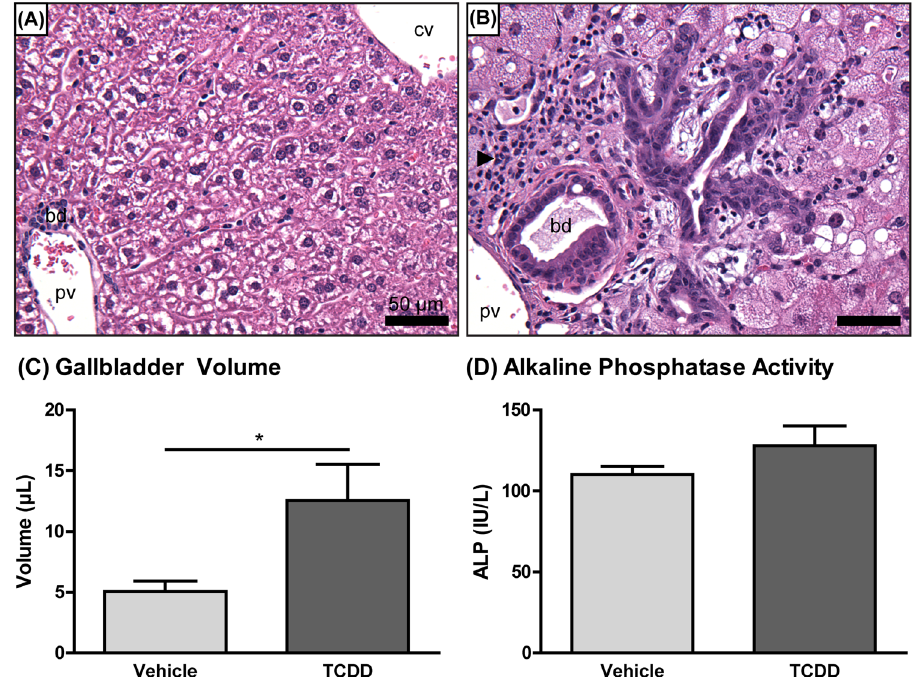
Figure 2. Representative photomicrographs of hematoxylin and eosin-stained livers from male C57BL/6 mice orally gavaged with ( A ) sesame oil vehicle or ( B ) 30 µ g/kg TCDD every 4 days for 28 days. Bile duct proliferation and pericholangitis (arrow) were identified at 30 µ g/kg TCDD. cv = central vein; pv = portal vein; bd = bile duct; bar = 50 µ m. ( C ) Gallbladder volume and ( D ) serum alkaline phosphatase (ALP) activity of male C57BL/6 mice orally gavaged with sesame oil vehicle or 30 µ g/kg TCDD every 4 days for 28 days. Bars represent the average ± standard error of the mean for at least 5 biological replicates. Statistical significance ( * p ≤ 0.05) was determined using a Student’s t-test performed in SAS